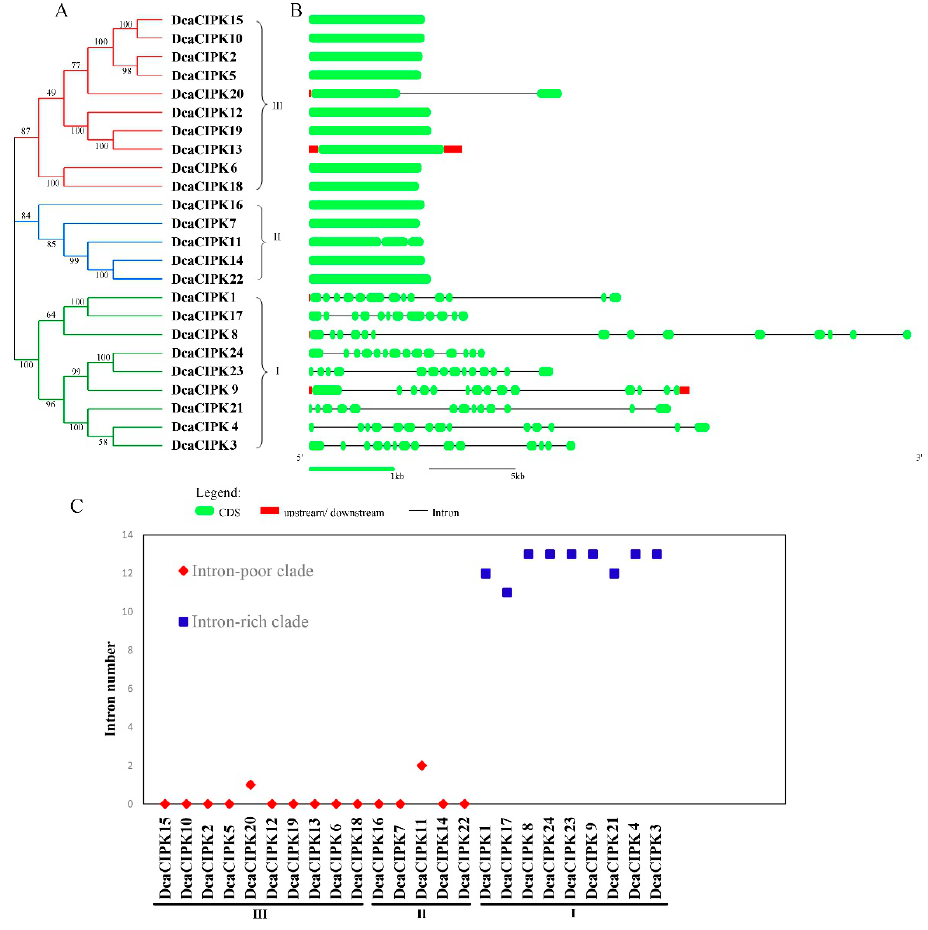
Figure 1. Phylogenetic relationship of D. catenatum CIPK proteins and gene structure. ( A ) Neighbor-joining tree. D. catenatum CIPK genes were divided into three subgroups (I–III) with different colored branches. ( B ) Exon and intron analysis was performed using GSDS. Green boxes represent exons and black lines represent introns. Red boxes represent upstream/downstream-untranslated regions. ( C ) Classification of CIPK genes into an intron-poor clade (red diamond) and an intron-rich clade (blue squares).